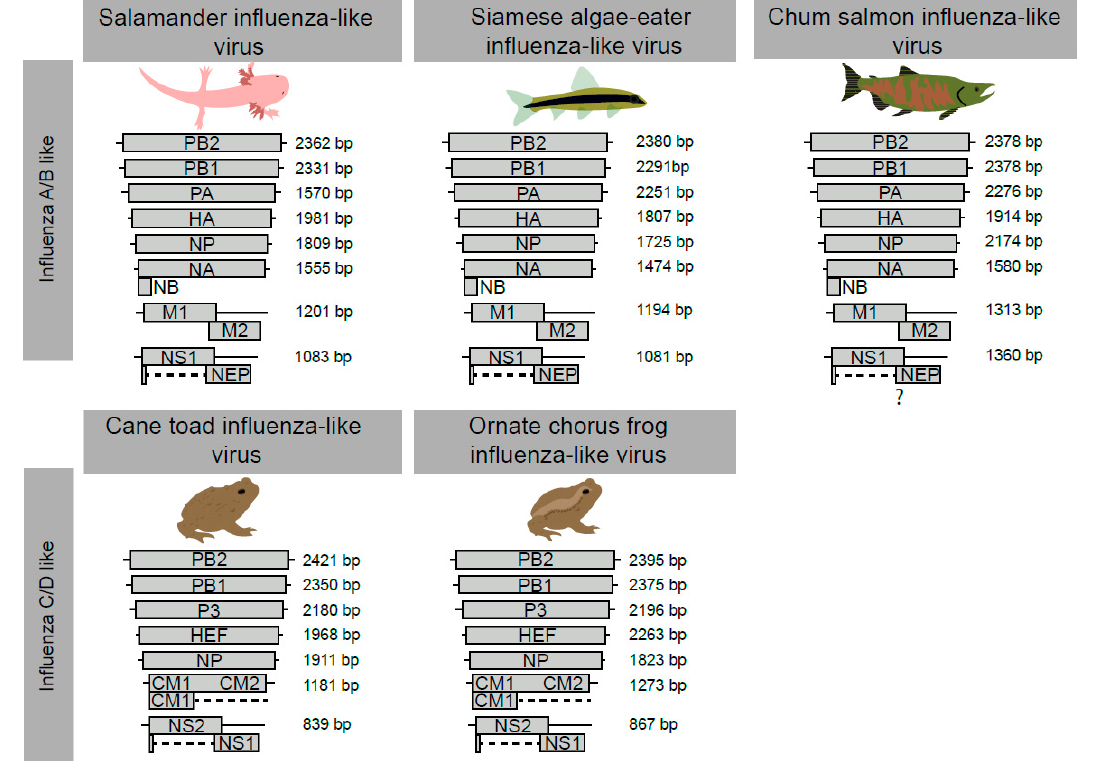
Figure 1. Genome architecture of the novel influenza-like viruses identified here. Genome architecture of influenza A virus (IAV) / influenza B virus (IBV) and influenza C virus (ICV) / influenza D virus (IDV) is shown on the left. For each novel virus, we provide the segment name and size. PB1, RNA-dependent RNA polymerase basic subunit 1; PB2, RNA-dependent RNA polymerase basic subunit 2; PA, RNA-dependent RNA polymerase acidic subunit; P3, Polymerase protein 3; NP, nucleoprotein; HA, hemagglutinin; NB, glycoprotein NB; HEF, hemagglutinin esterase; NA, neuraminidase; M, matrix; CM1, viral matrix protein; NS, non-structural protein; NEP nuclear export protein. Detailed annotations for each virus are presented in Supplementary Tables S1–S6 and Figures S1–S5.